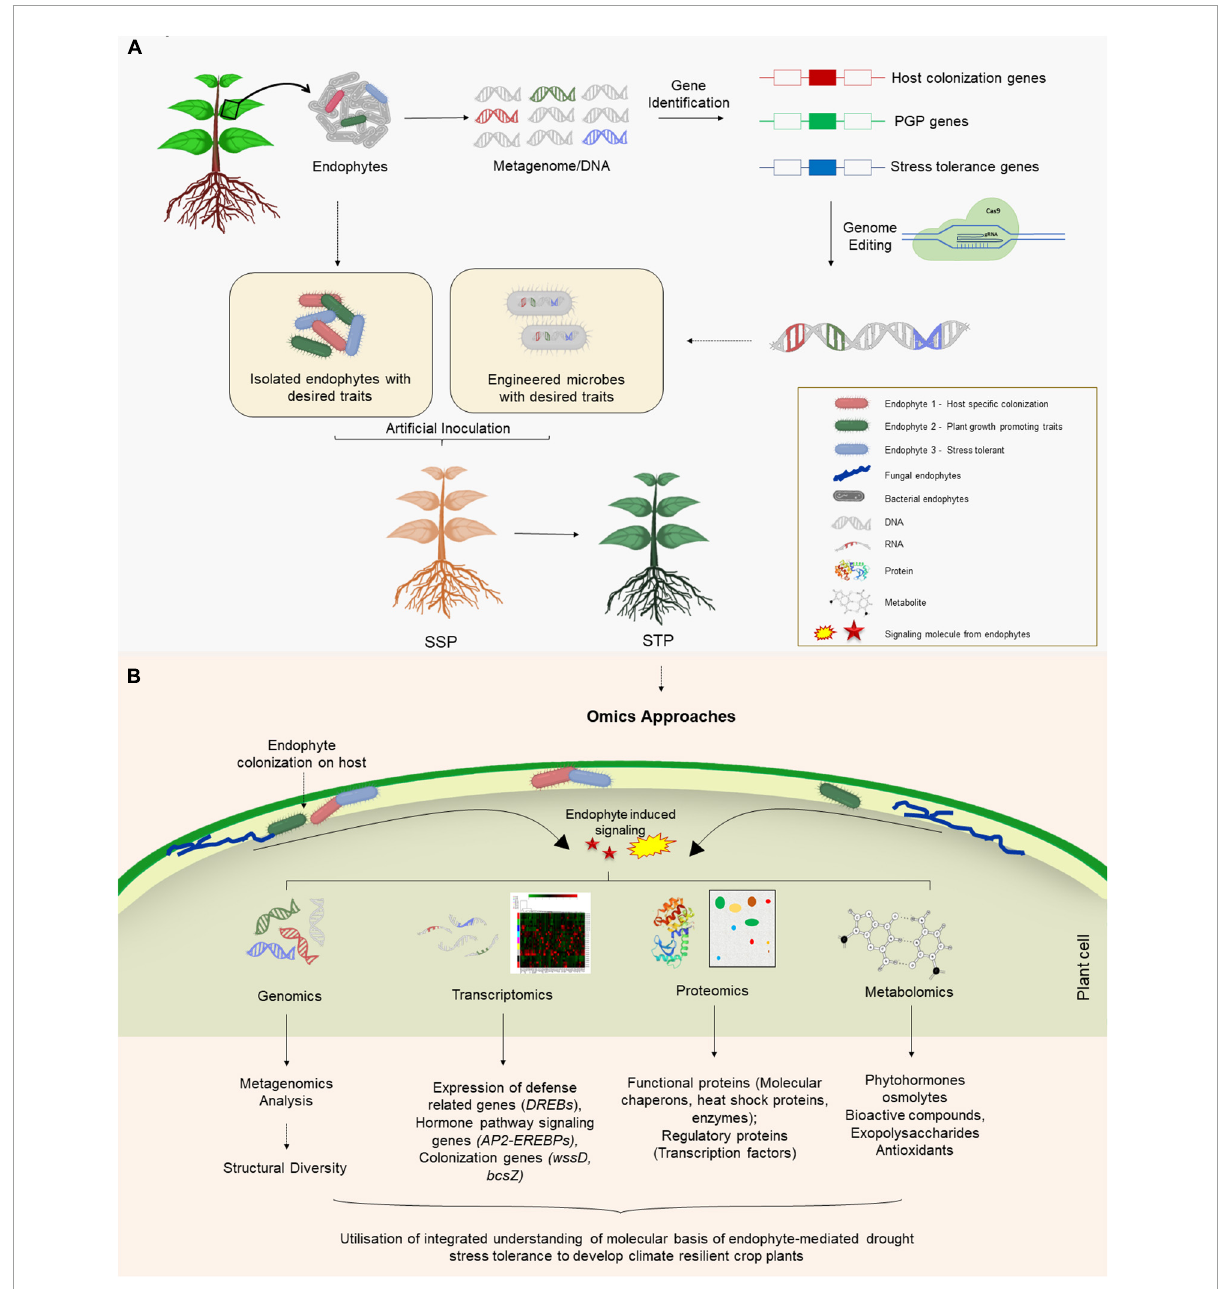
FIGURE2 (A) Application of endophytes for mitigating drought stress in crop plants. Endophytes naturally inhabiting plants in water deficit regions may be isolated and genes involved in host colonization, growth promotion and stress tolerance can be identified. Through the genetic engineering/genome editing of the candidate gene(s), the information can be utilized to engineer microbes that have ability to colonize non-host crop plants, promote their growth and confer stress tolerance. Additionally, the naturally isolated endophytes can also be used to produce stress tolerant crop plants. (B) Application of omics-based approaches to understand molecular basis of endophyte-mediated drought